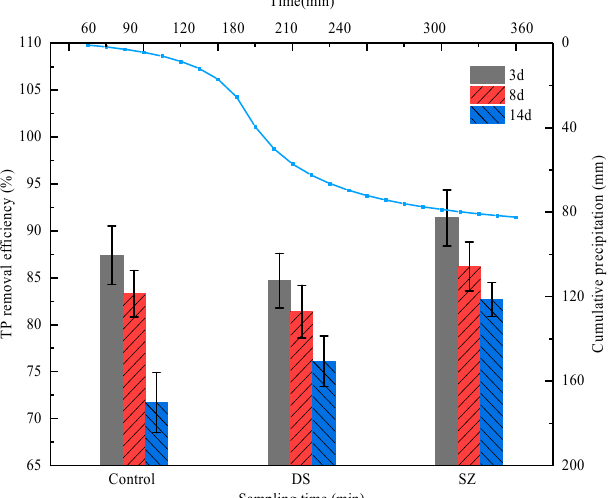
Figure 10. The efficiency of TP removal using bioretention systems with the Control column, DS column, and SZ column during different antecedent dry periods.